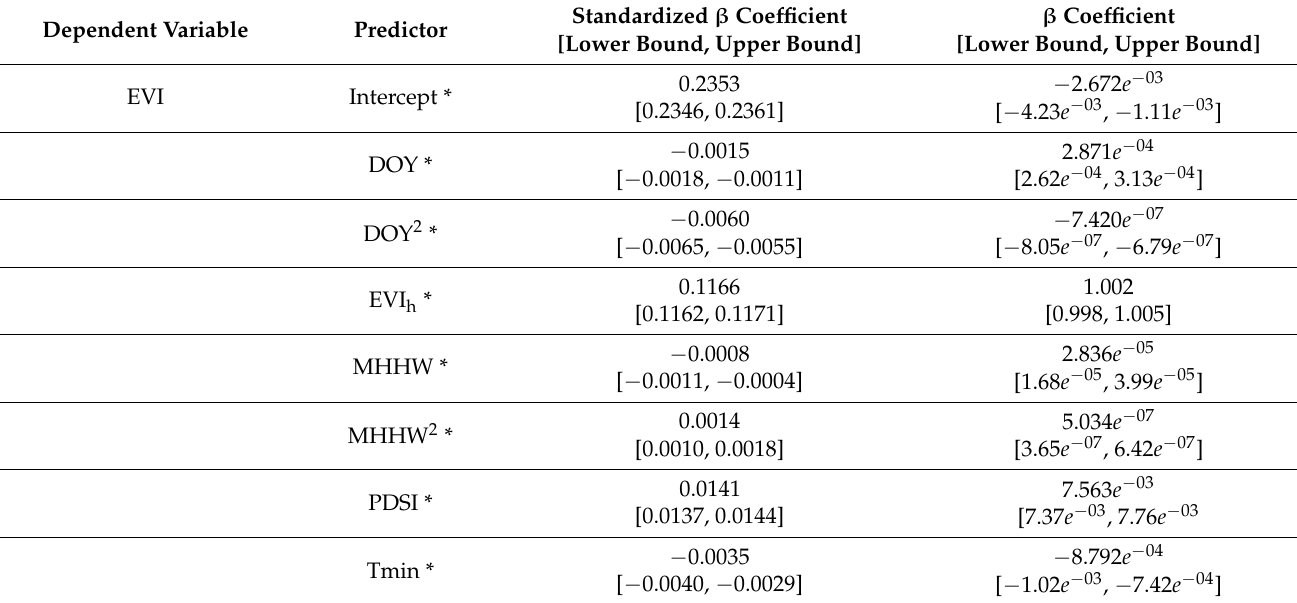
Table 2. Model coefficients for the best fit model. The top value for each row represents the standardized and unstandardized β coefficients for each predictor variable of the best fit model. The lower two values of each line represent the lower and upper bounds of the 95% confidence interval around each coefficient.